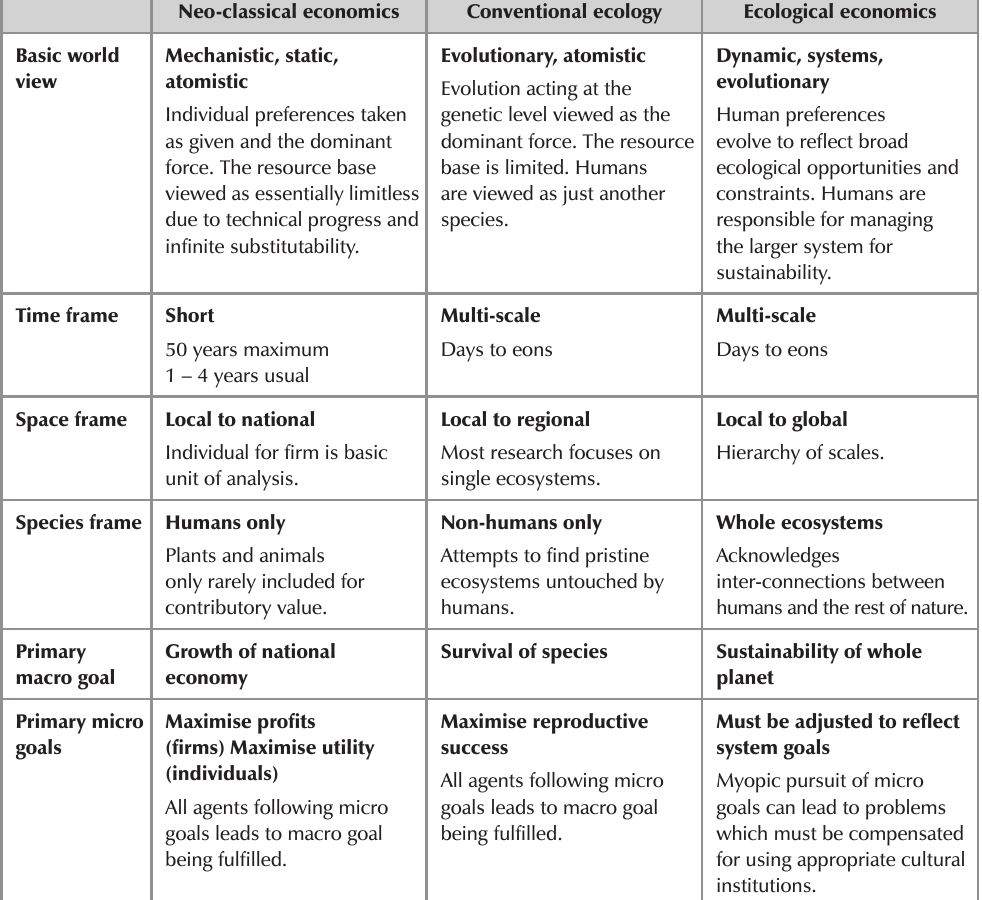
Comparison of neo-classical economics with ecology and ecological economics Neo‑classical